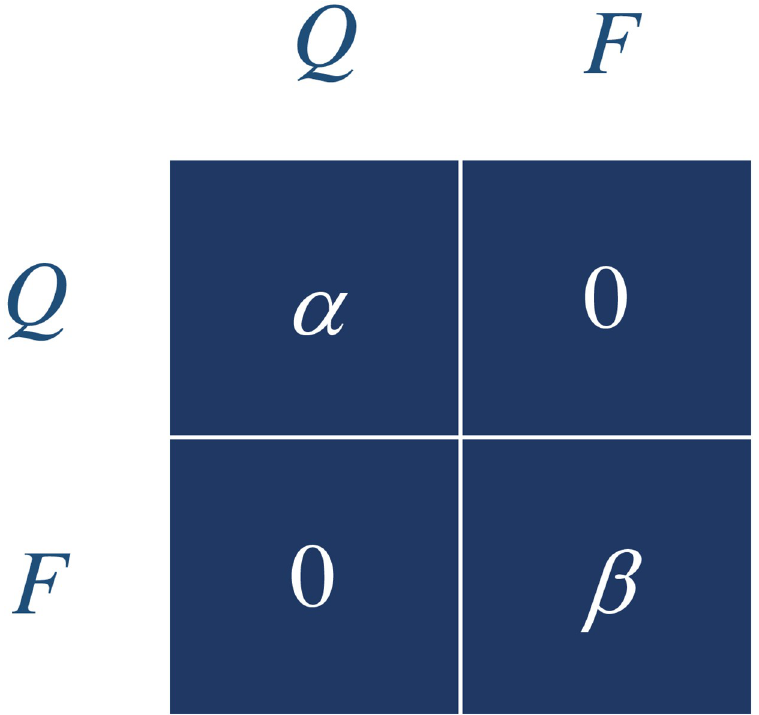
Fig 1. Social distancing game. A game with two choices of activities, either quarantine ( Q ) or free-social ( F ), can be described by a 2 × 2 table. The rows of the table correspond to the strategies played by an individual, while the columns to those by the population. A number is assigned to each cell to represent an estimate on the amount of social contacts the individual can make in the corresponding interaction. When the individual and population both choose to quarantine, the individual makes a small amount of social contacts α > 0. When they both participate in free social activities, the individual makes a large amount of social contacts β > α . In the other two cases, the individual makes zero social